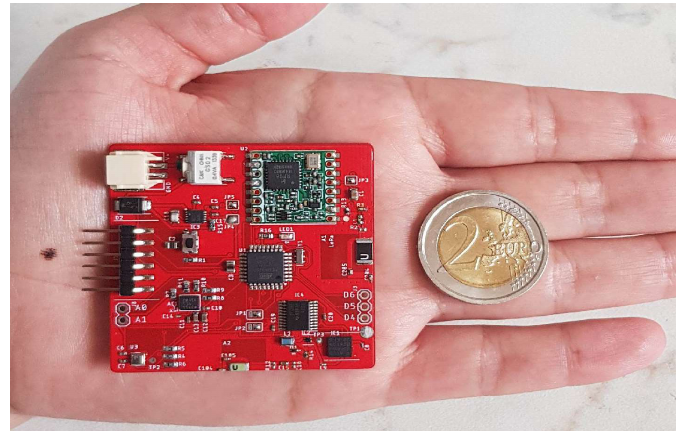
Figure 3. Top view of the PCB implementation of the radioprobe. Size, 50 mm × 50 mm. Weight, 7 g.